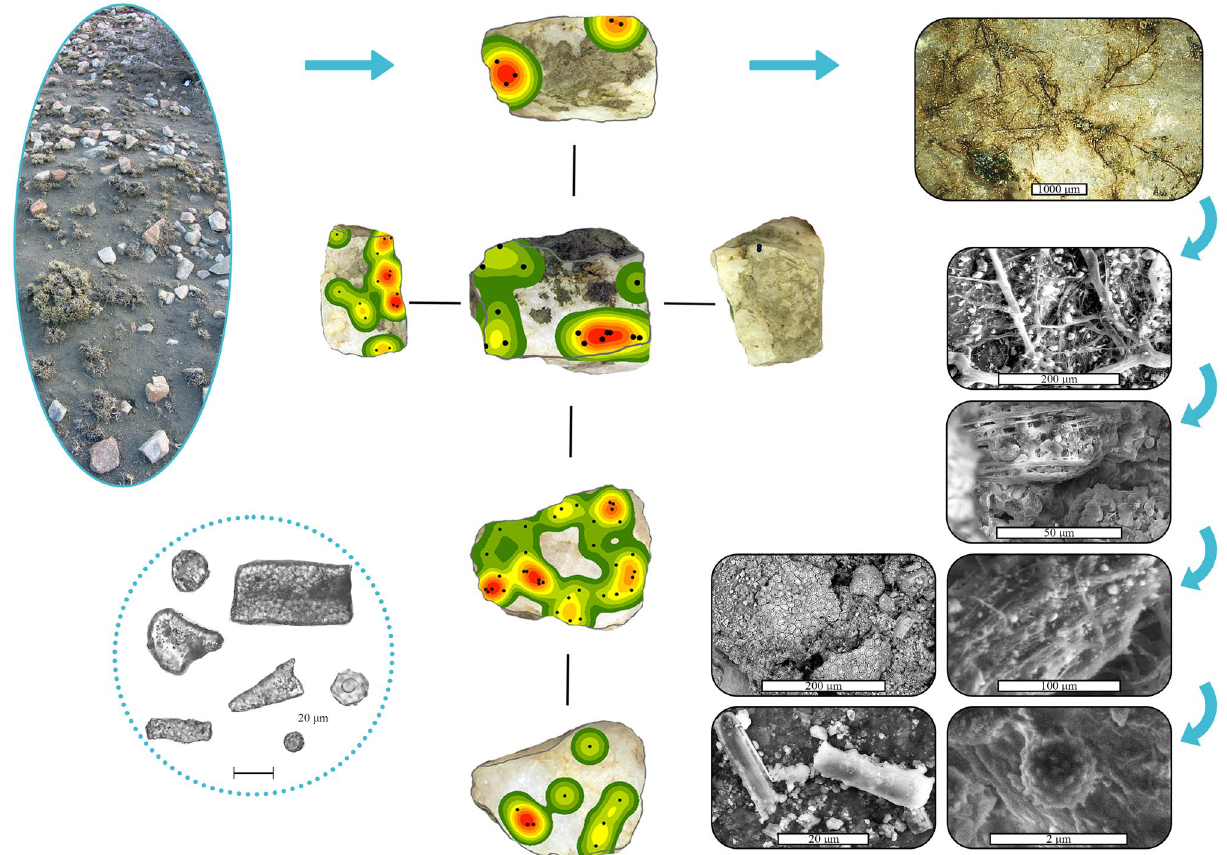
Figure 2. From surface rock to proxy microcosm. Ovate panel, upper left, shows a view of the surface prior to sampling; small bushes for scale. Center images: each subpanel shows a different facet/side of the rock labelled as East 31 (see Fig. 1, center right for provenance). Statistical analysis of georeferenced residue at the mm scale confirms dispersed scatters, in which the areas shown in red hold the highest density, dark green the lowest. Rectangular panels, from top right to bottom right, reveal microcosms from lichens, trapping spores of diverse morphologies, phytoliths, and epidermal tissue. Microlaminations precipitated successively, sandwiching microbotanical remains. Microbial exudates are apparent. Lower left circle shows a compilation of phytoliths, including globular and tabular shapes, together with scutiform and bulliform